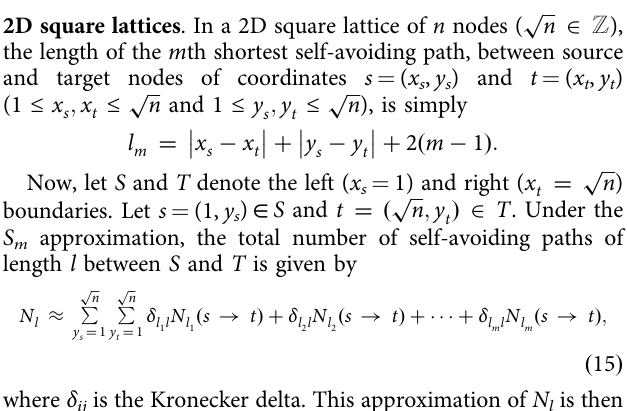
ffiffiffi p 2 Z ), n